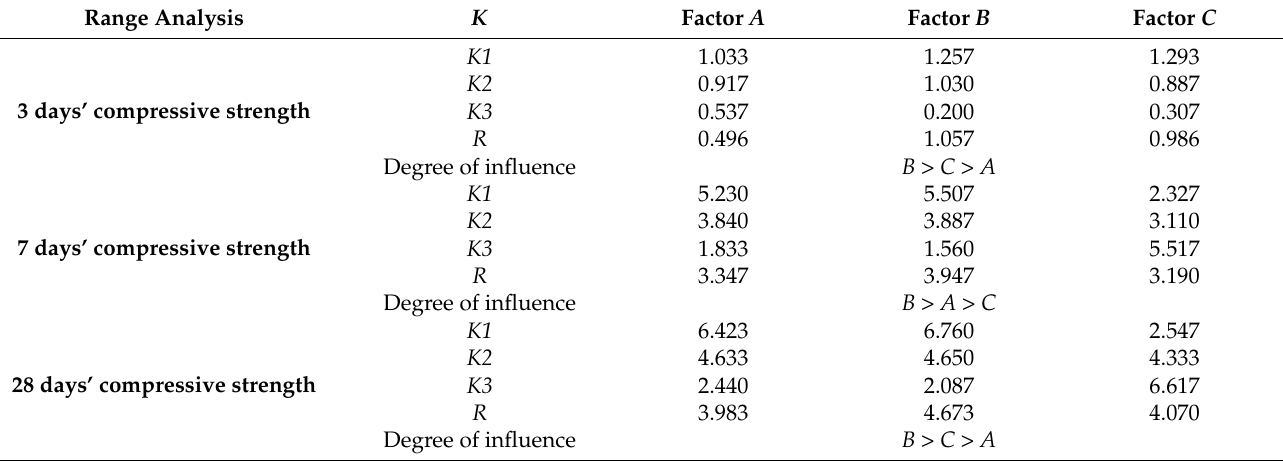
Table 7. Analysis of range difference of compressive strength at each